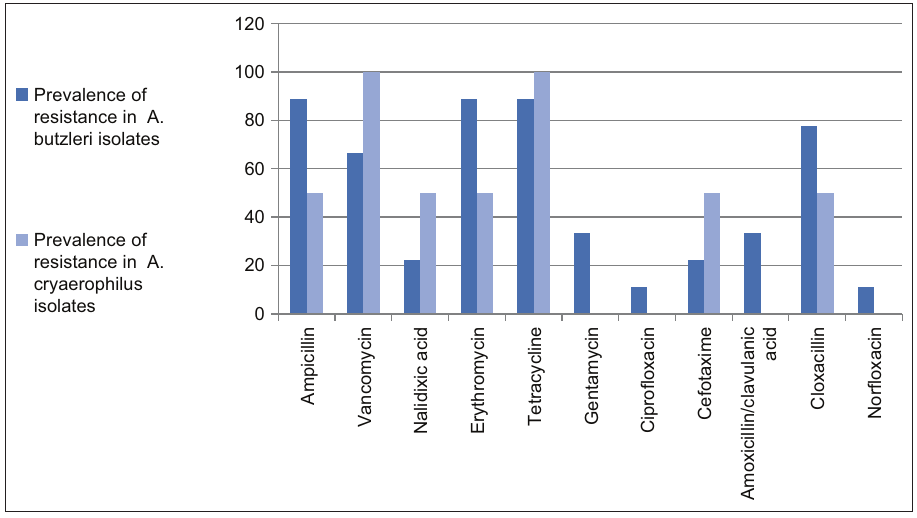
Figure-1: Prevalence of resistance in Arcobacter isolates based on